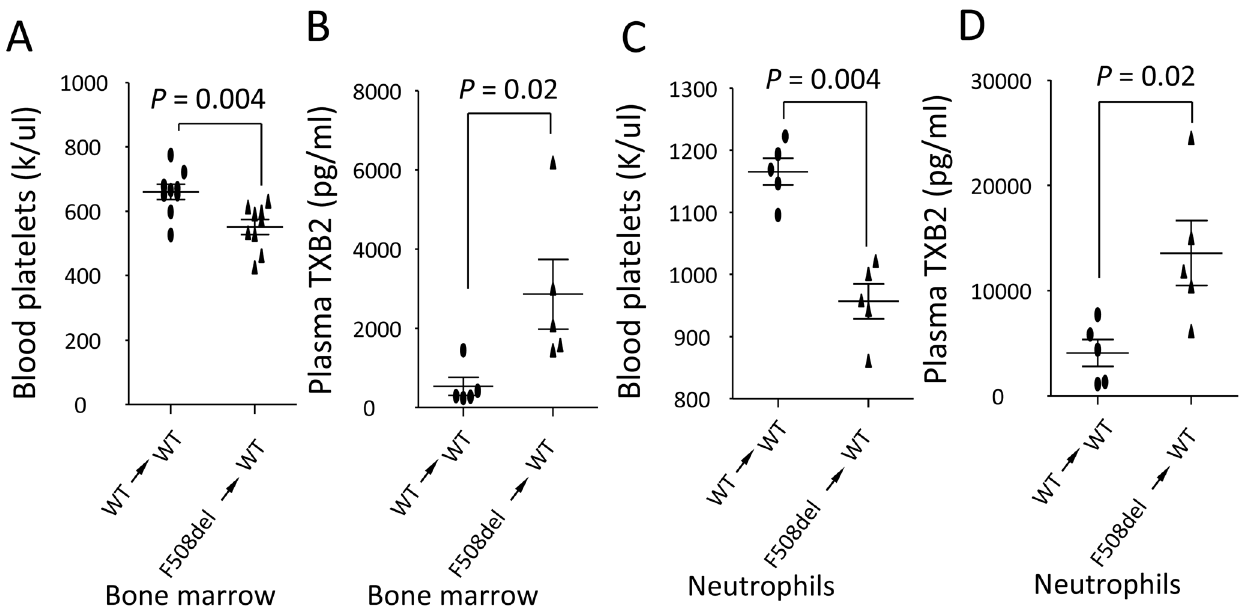
Figure 3. F508del bone marrow-derived cells, specifically neutrophils, play an important role in mediating thrombocytopenia. A–B. Wildtype mice were irradiated and then reconstituted with wildtype or F508del bone marrow to create chimeric mice. At 24 h after LPS challenge, wildtype mice receiving F508del bone marrow developed thrombocytopenia (A) (N=9 in each group) with higher plasma TXB2 levels (B) (N=5 in each group) compared to wildtype mice receiving wildtype marrow. C–D. Wildtype mice were given anti-Gr-1 antibody to deplete neutrophils and then reconstituted with either wildtype or F508del neutrophils. 24 h after LPS challenge, wildtype mice receiving F508del neutrophils developed thrombocytopenia (C) and had higher levels of plasma TXB2 (D). N=5 in each group. Data were analyzed by t-test and presented in mean 6 SD. P values are listed on each panel.